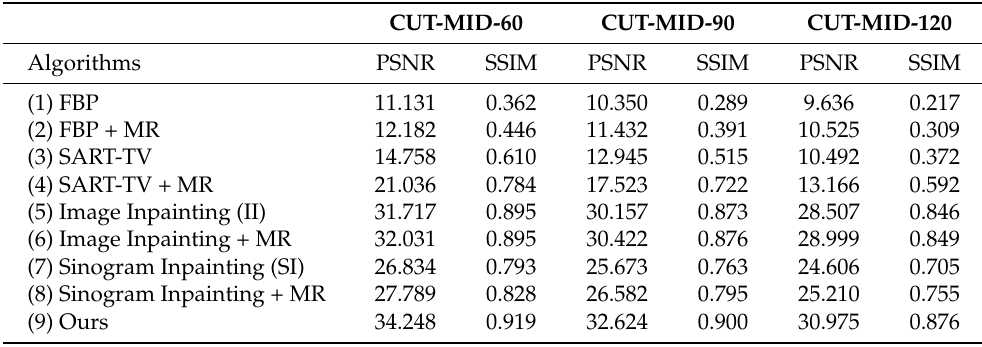
Figure 13. Histograms of different algorithms applied to different data preprocessing methods on different input data. Table 8. Restoration results of various algorithms for limited-view data with varying degrees of